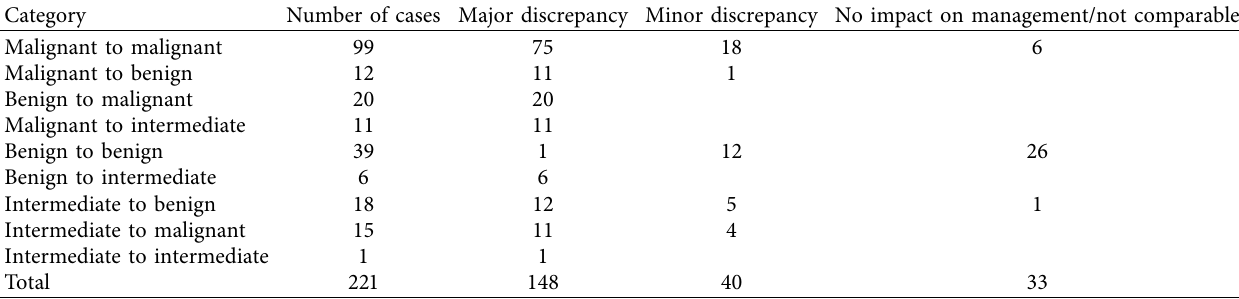
Table 8: Changes in assignment of tumor behavior.